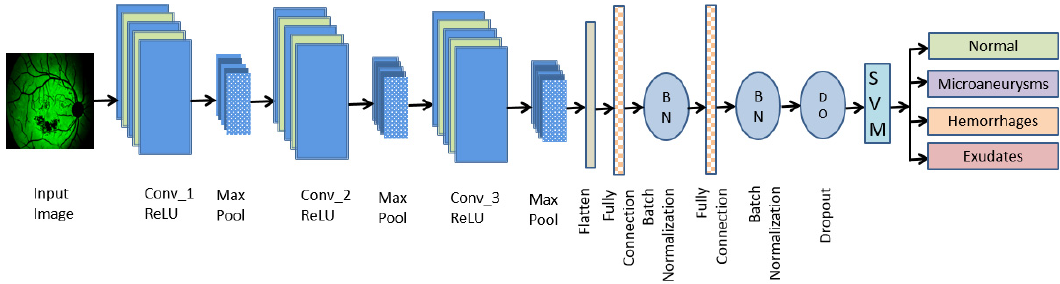
Figure 5. Deep CNN with SVM